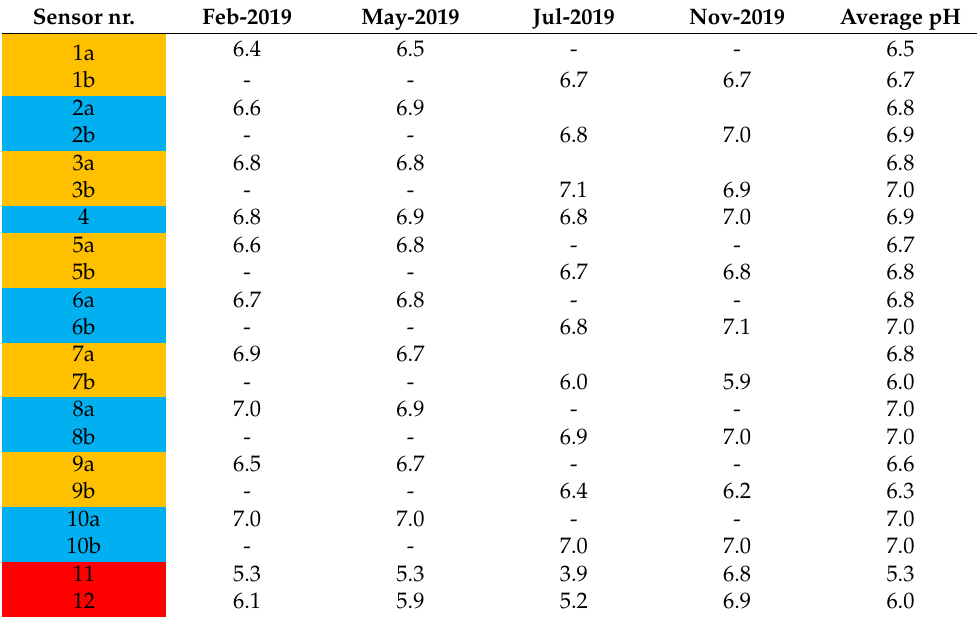
Orange = Inside showcase. Blue = Hall free environment. Red = Outdoor. - Not